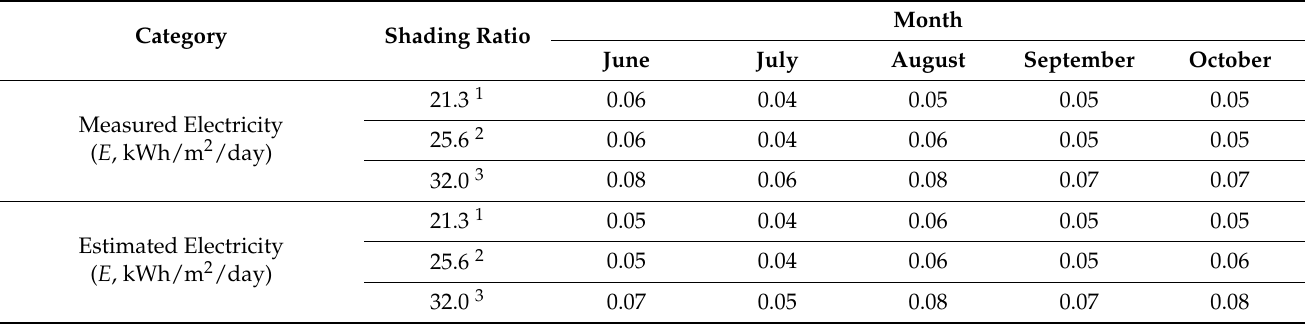
Table 5. The measured amount of electricity quantity and the estimated amount of